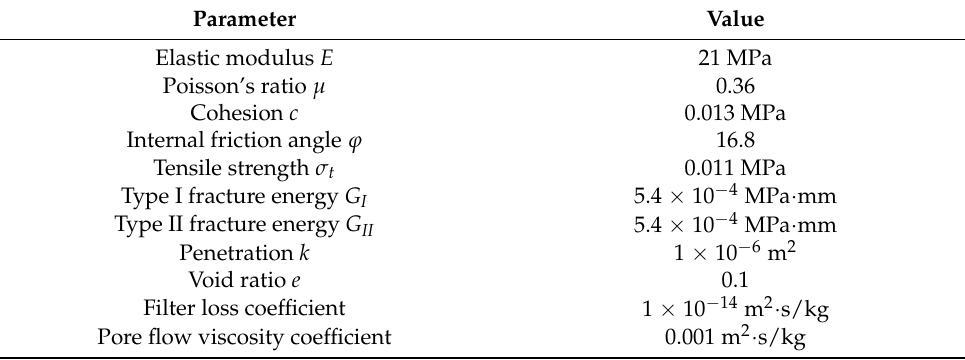
Table 4. The parameters of the cohesive soil layer at the position EK4 + 820.